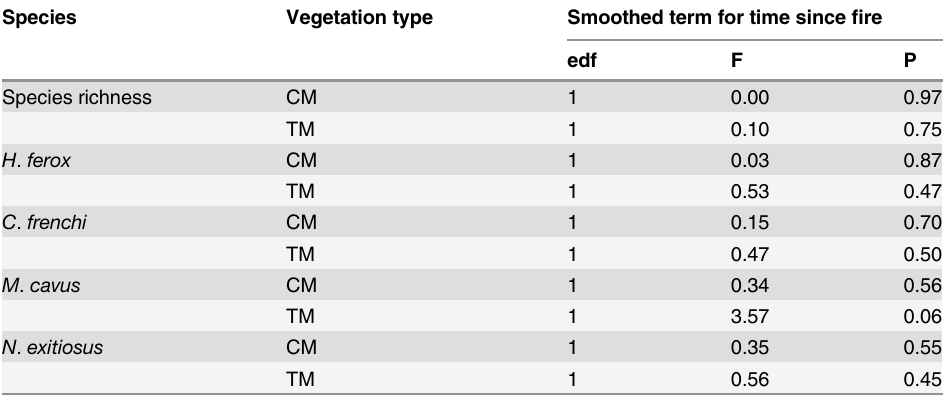
Table 3. Summary of generalised additive mixed models of the species richness of termites and the presence/absence of individual species of termites in relation to time since fire, rainfall and